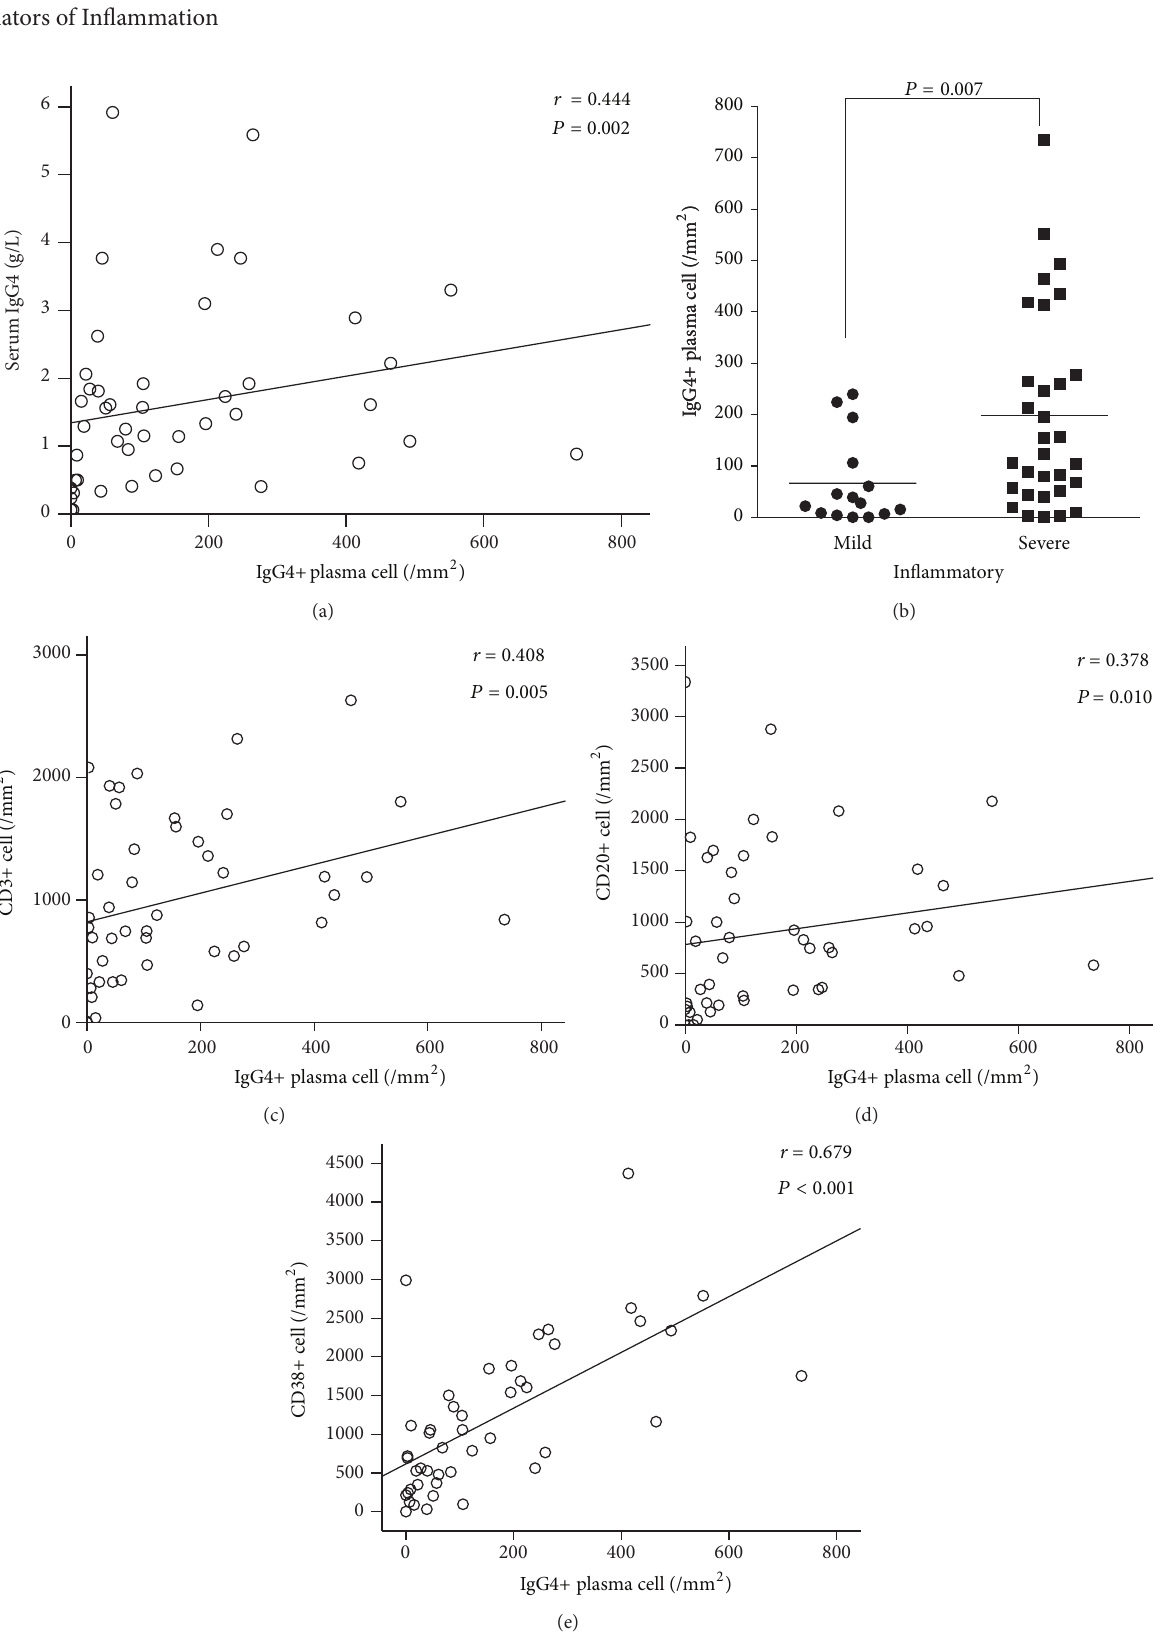
Figure3:CorrelationofIgG4-positiveplasmacellswithserumIgG4andinflammatoryinfiltrationinsynoviumof46RApatients.Spearman’s rankordercorrelationtestshowedsignificantcorrelationofIgG4-positiveplasmacellswithserumIgG4(a),CD3+(c),CD20+(d),andCD38+ cells (e). Patients with severe inflammatory infiltration ( 𝑛 = 31 ) had higher IgG4-positive plasma cells than those with mild inflammatory infiltration in synovium ( 𝑛 = 15 )